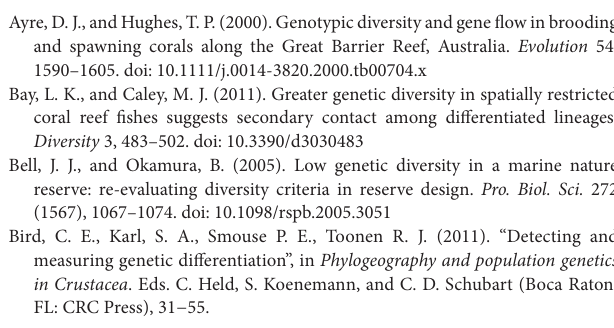
SUPPLEMENTARY FIGURE 1 | Cross validation (CV) error plot from Admixture analysis showing number of population of L.mahsena collected from marine protected areas and exploited fishing